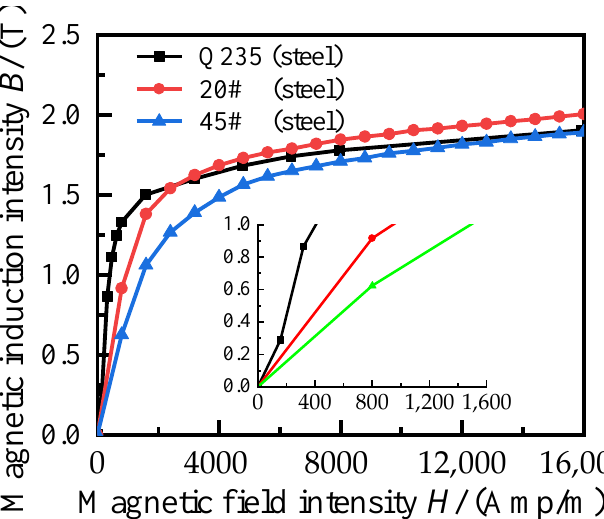
Figure 3. Magnetization curves of materials. The material properties, as well as the magnetization curve and magnetic flux density– shear yield stress curve, for MRF-J01T provided by MRF for Chongqing Instrument Materi- als Research Institute, are shown in Figure 4.